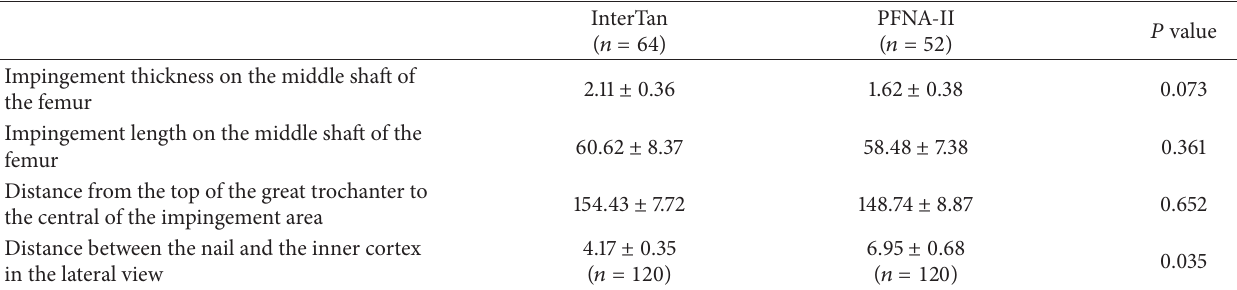
Table 2: The average fitness value on the middle and distal portion of the implant